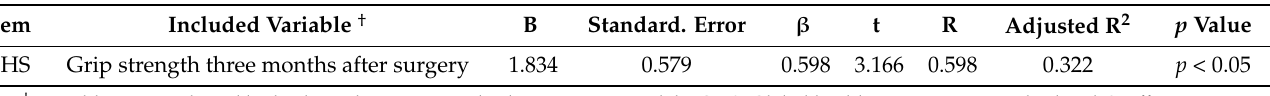
Table 2. Factors predicting of QOL at three months after